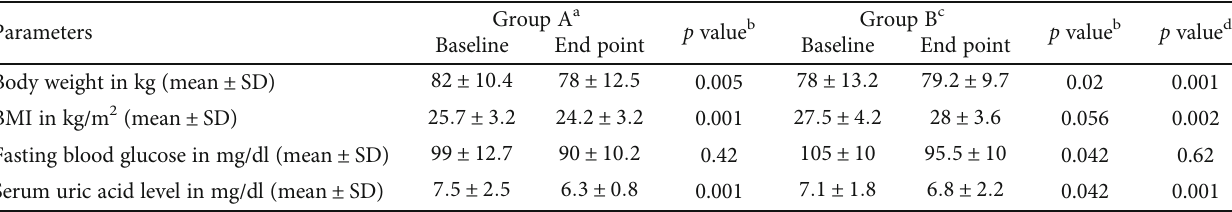
Table 2: Comparison of uric acid changes at baseline and after